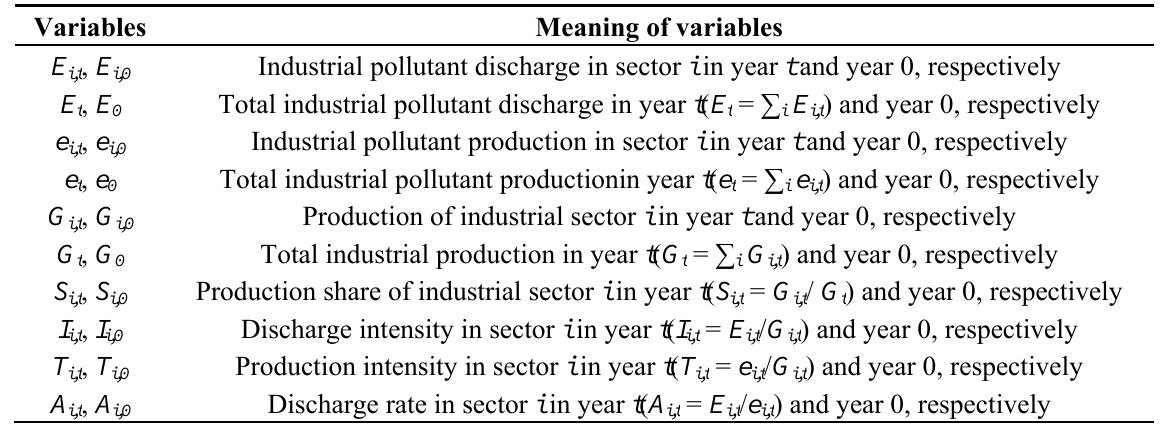
Table 1. Summary of notations and